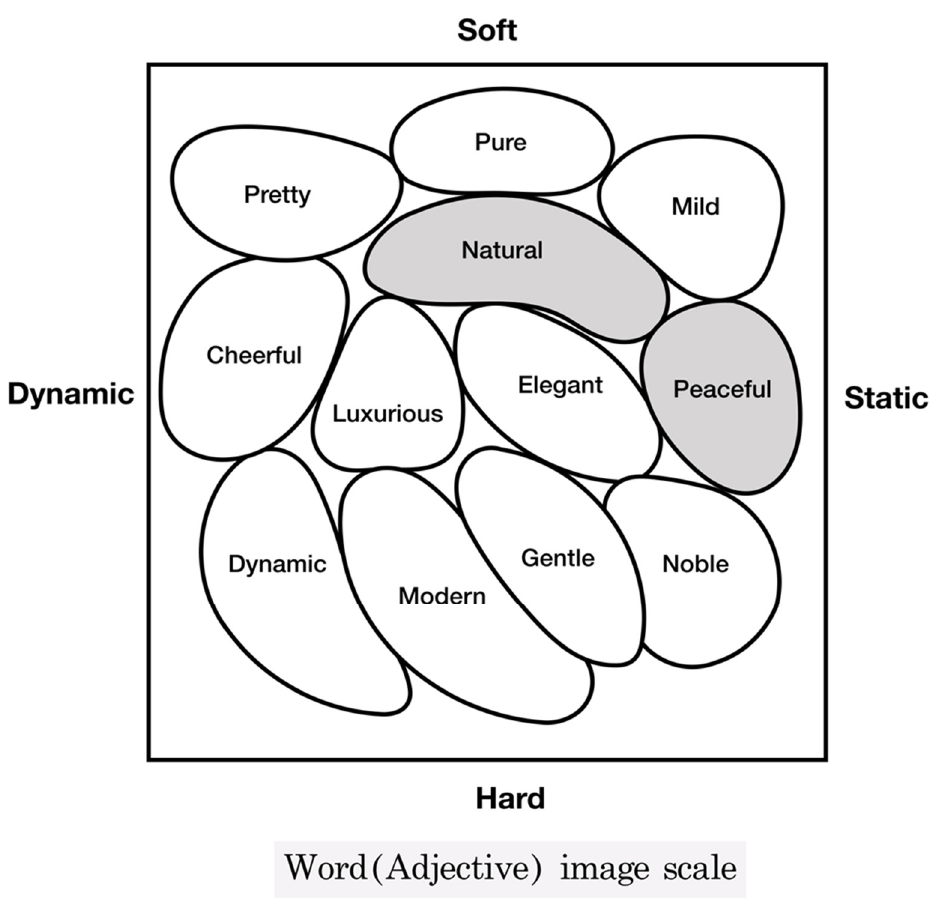
Figure 7. IRI word (adjective) image scale for dental unit chair. According to the “psychological color image analysis using the IRI color image